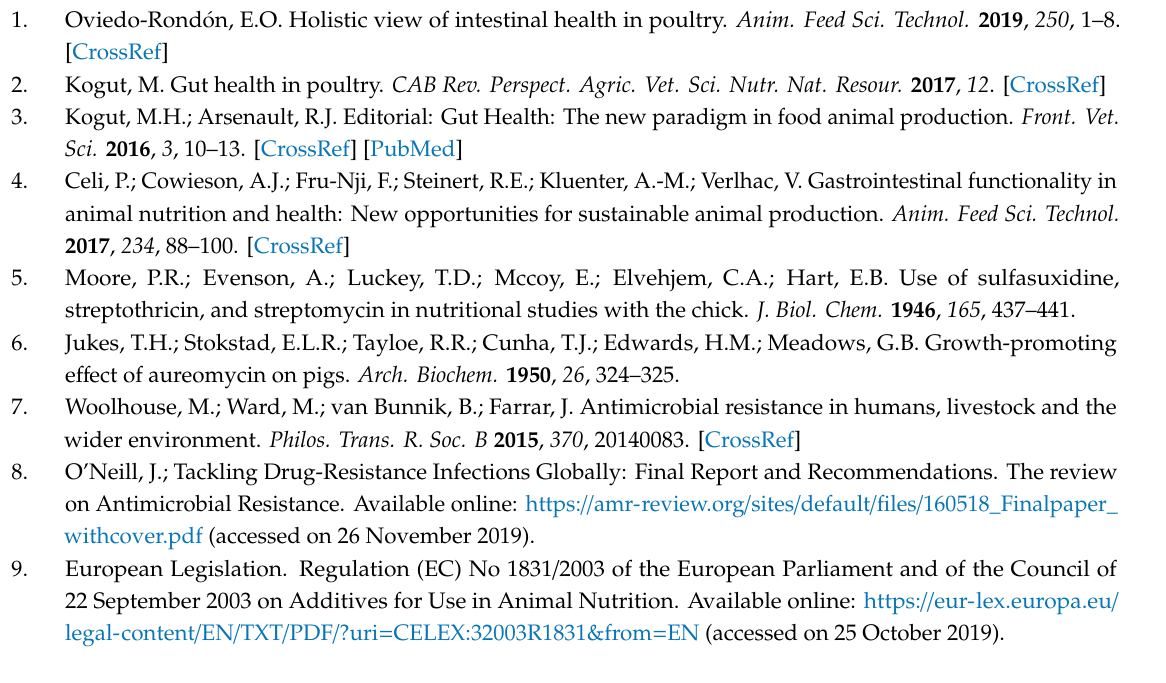
Table S1: Plasma metabolomics profiles according to replication; Table S2: Mean relative frequency of abundance (%) of phyla, classes, orders, genera, and species of caecal bacteria in 42-day old broilers belonging to groups A and D; Figure S1: Caecal bacteria with > 0.1% mean relative frequency of abundance in A vs. D groups. Author Contributions: Conceptualization, B.S., L.V. and F.S.; data curation, G.B., A.D.C., M.Z., L.L., C.Z.